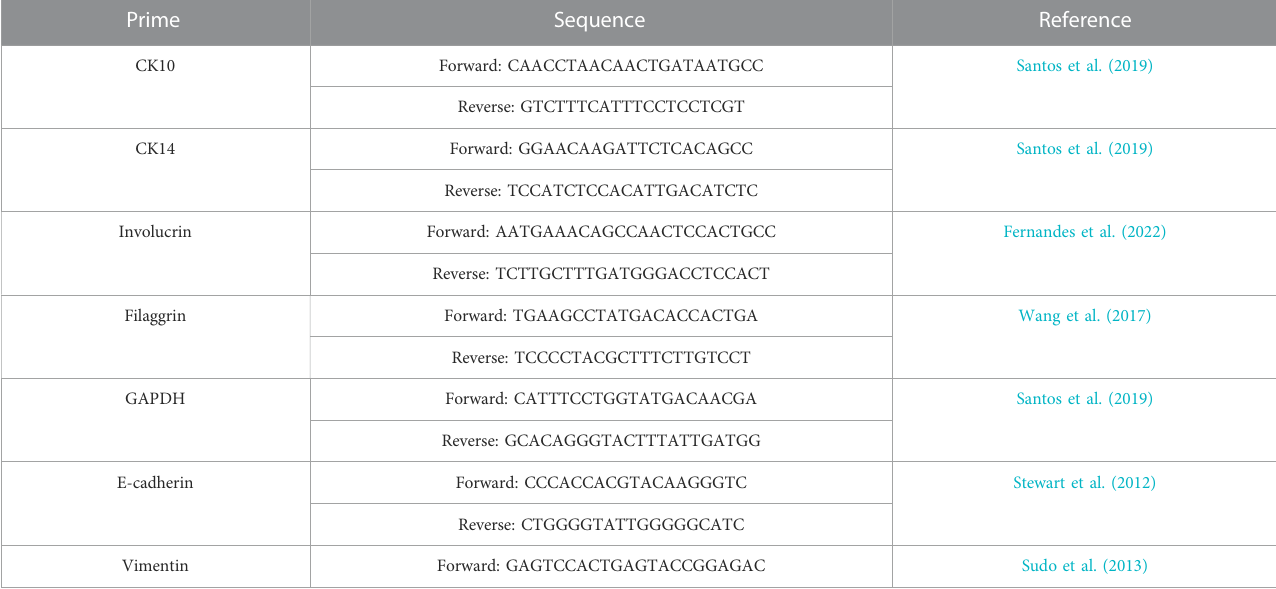
TABLE 1 Sequences of oligonucleotides used in qPCR experiments. Prime